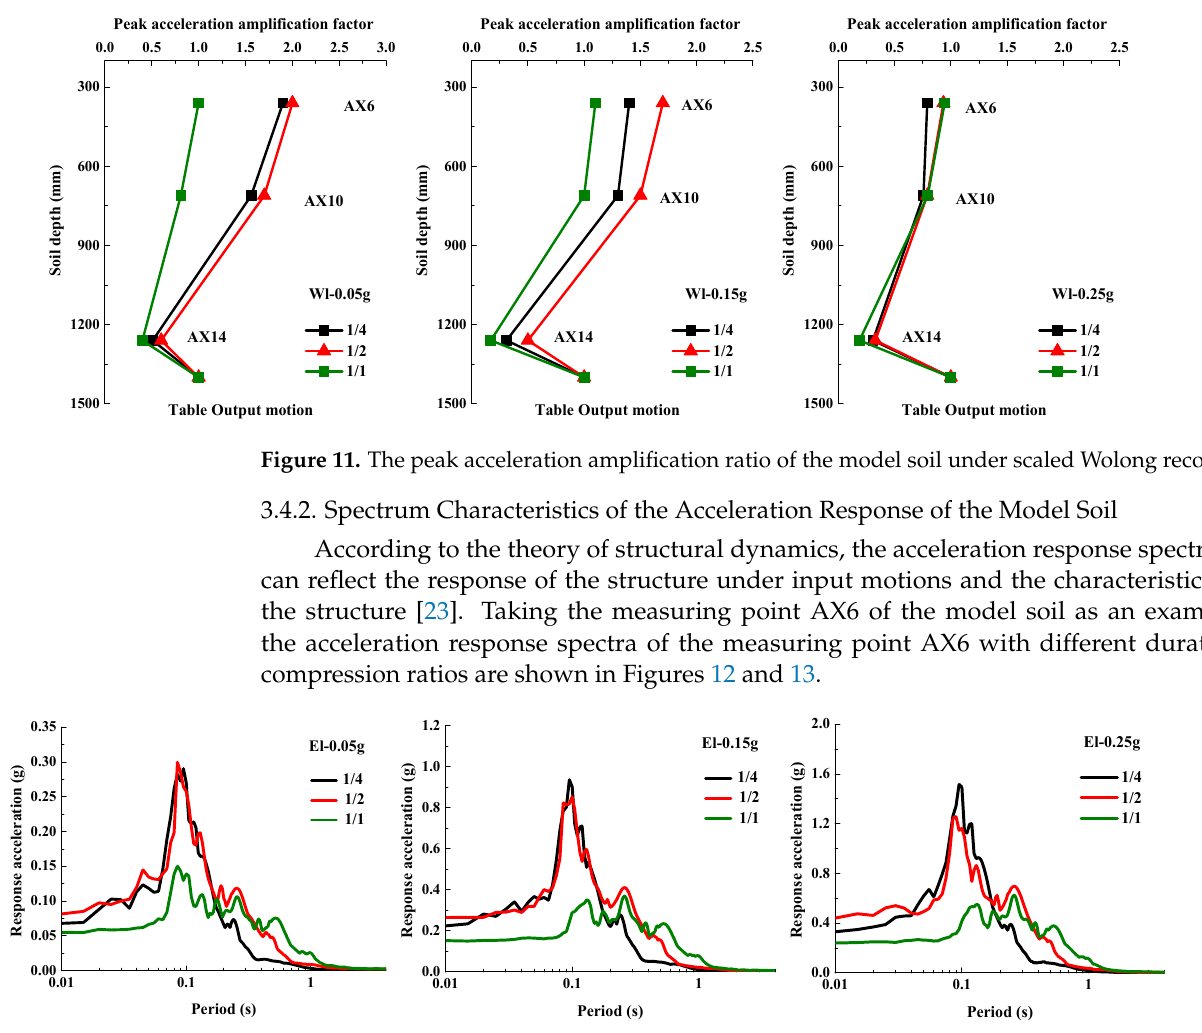
Figure 12. Acceleration response spectra of the measuring point AX6 under scaled El Centro rec- ords.